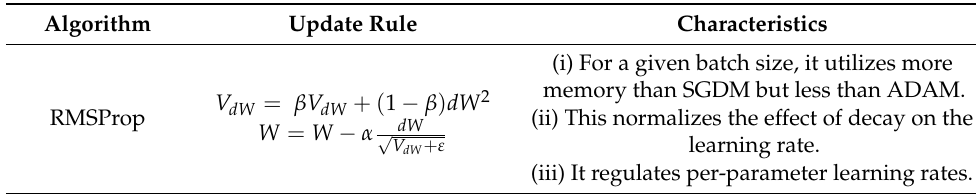
Table 2. Definition of optimization